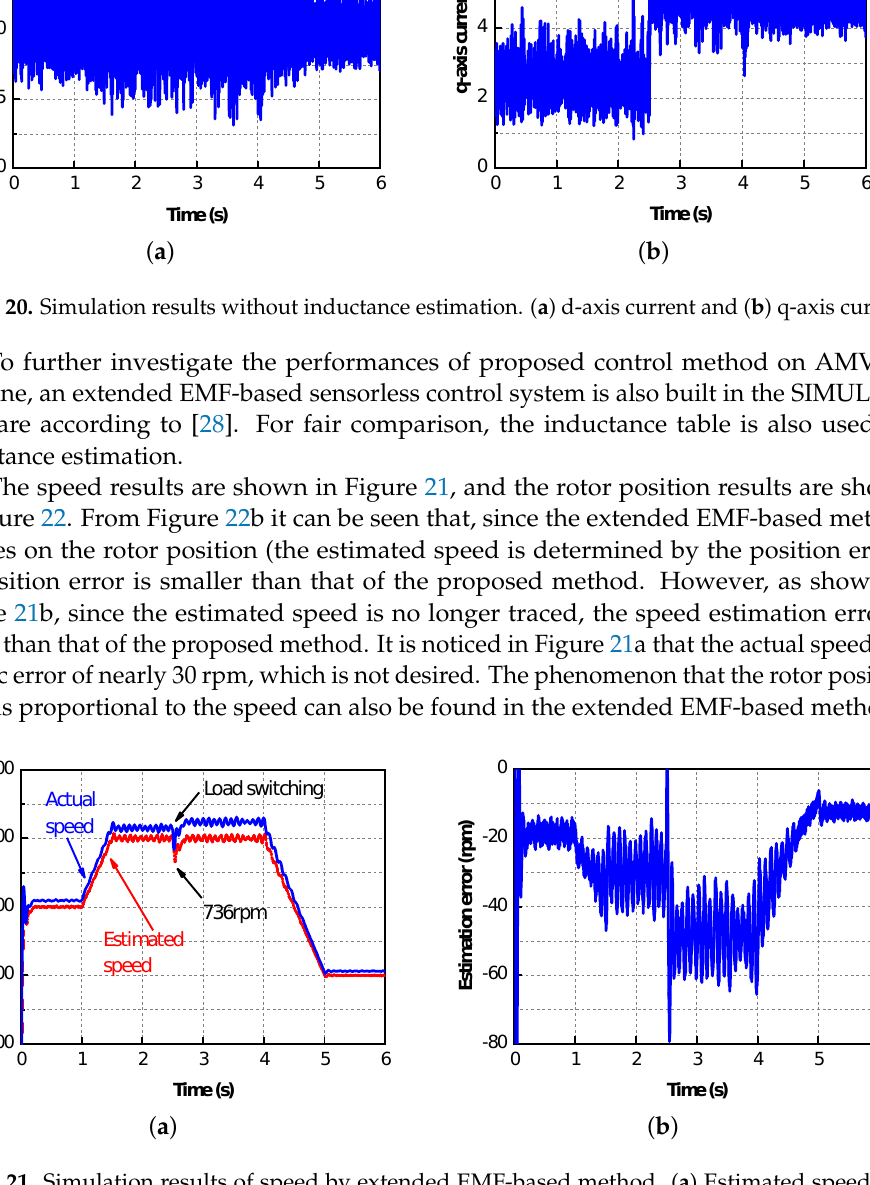
Figure 21. Simulation results of speed by extended EMF-based method. ( a ) Estimated speed and ( b ) estimation